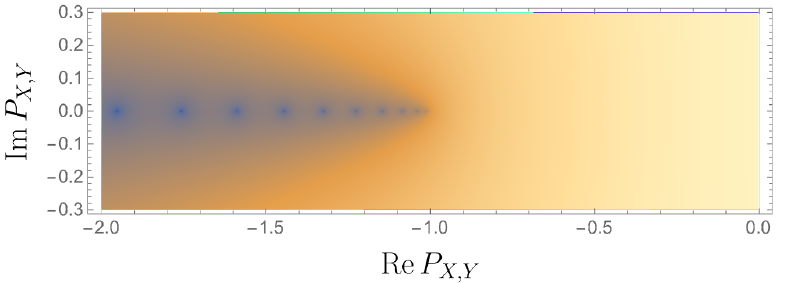
Figure 4 . Density plot of | G ( P X,Y ) | for d = 4 and m = 25 . In the large- m limit zeroes (blue dots) accumulate near P X,Y = − 1